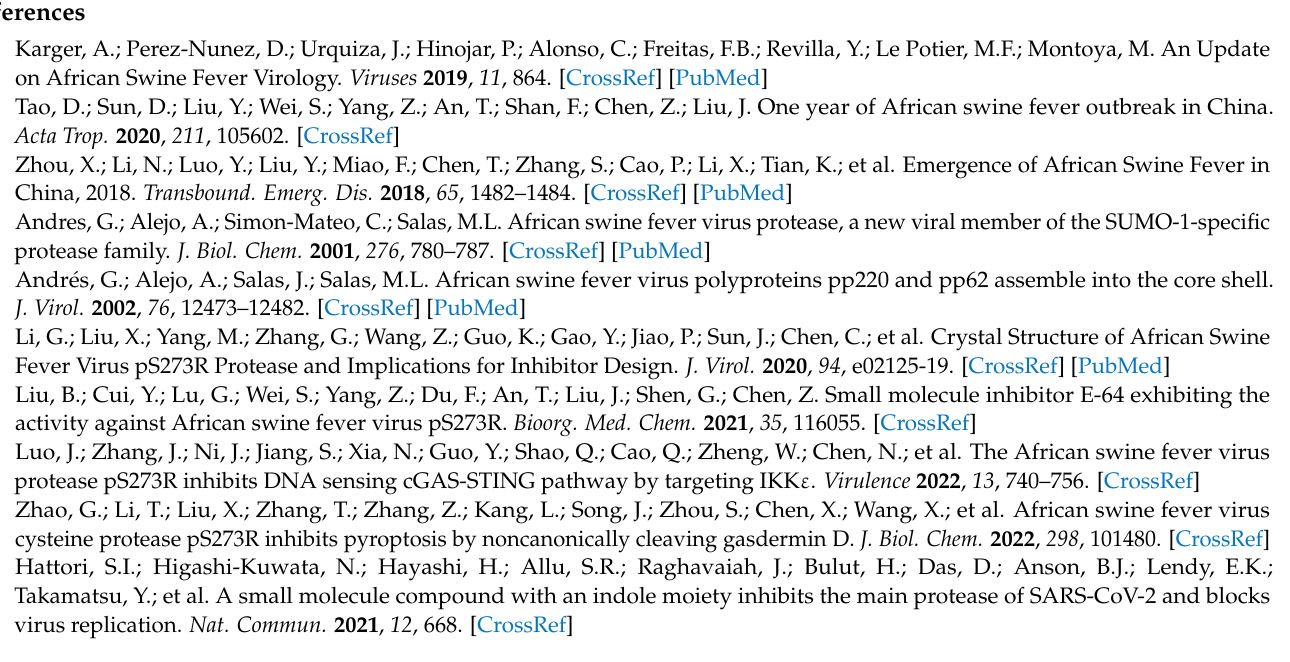
Table S2: Complex simulations of the average structure extracted with the RMSD of the initial struc- ture of pS273R(Crystal (6LJ9A),Cluster1 and